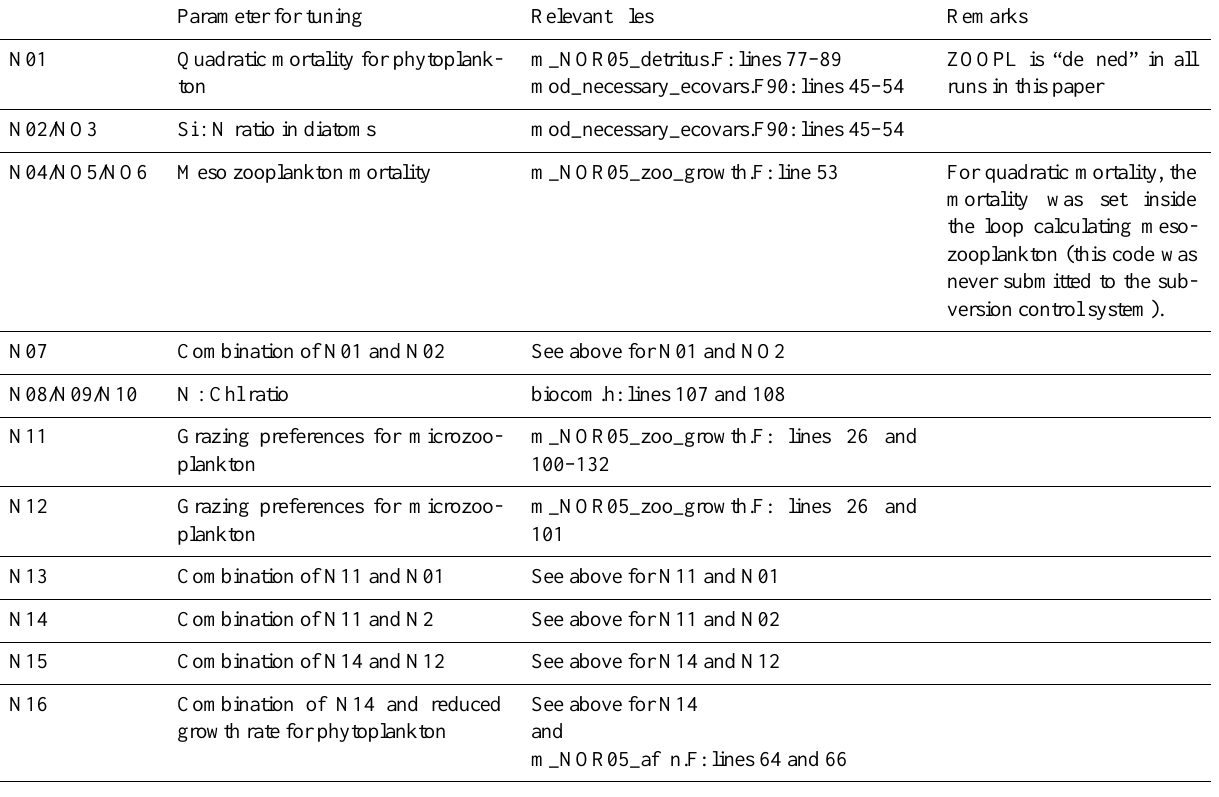
Table A1. Location of changes in the model code, all files are located at